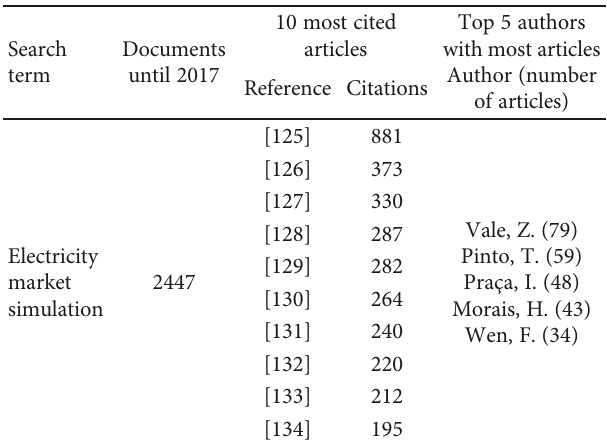
Figure 7: Documents related to electricity market simulation in the SCOPUS database until 2017. Table 8: Overview of the most cited documents and top authors related to electricity market